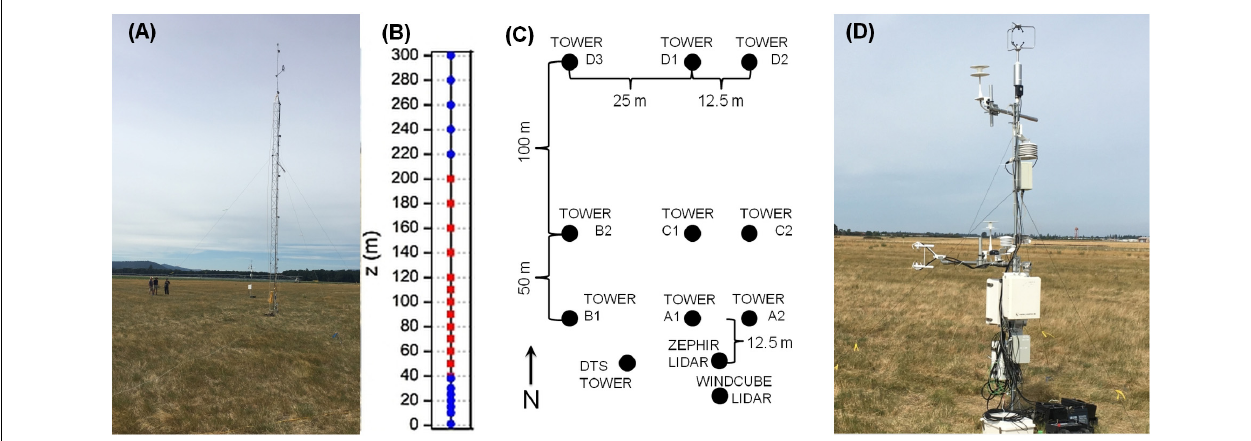
FIGURE 2 | Schematic of the 3-D measurement domain showing (A) a north facing view of the DTS tower, (B) the vertical extent of the domain as a virtual tower with ZephIR300 measurements in blue (circle symbol) and WindCube v2 heights in red (square symbol), (C) the horizontal domain showing the logarithmic spacing of the sonic array, and (D) a photograph of Tower